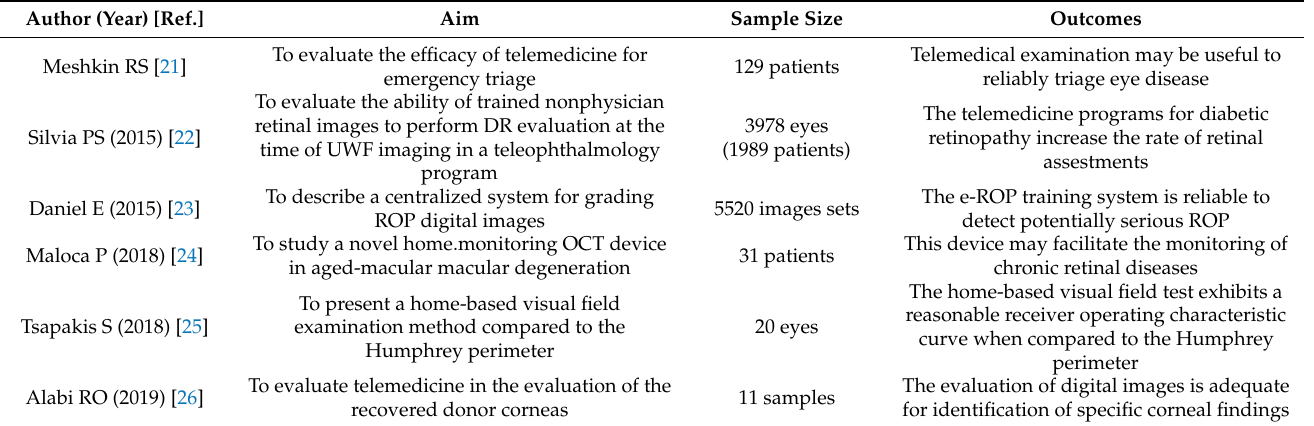
Table 1. Evaluation of the main ophthalmological clinical studies treated in the